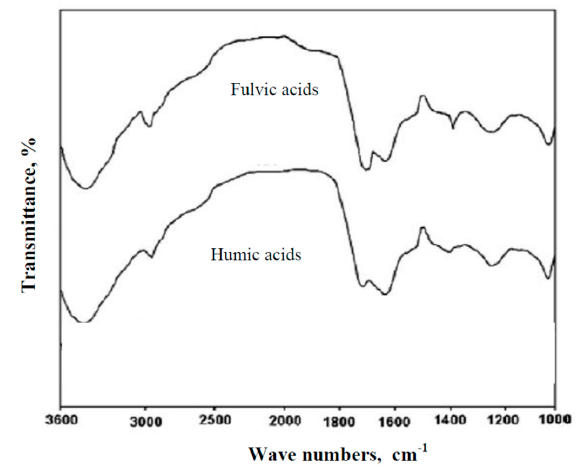
Figure 2. The IR spectra of humic and fulvic acids extracted from the groundwater.